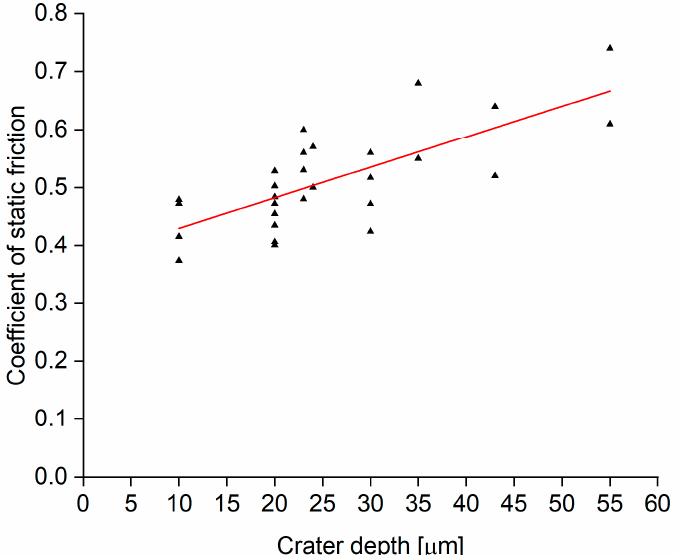
Figure 11. Static friction coefficient as a function of crater depth. The results presented here were obtained with both the 20 W and 200 W lasers. Results include various spot-to-spot spacings. The results for the same crater depth are for a range of different spot-to-spot spacings, hence the spread of coefficient of friction values.